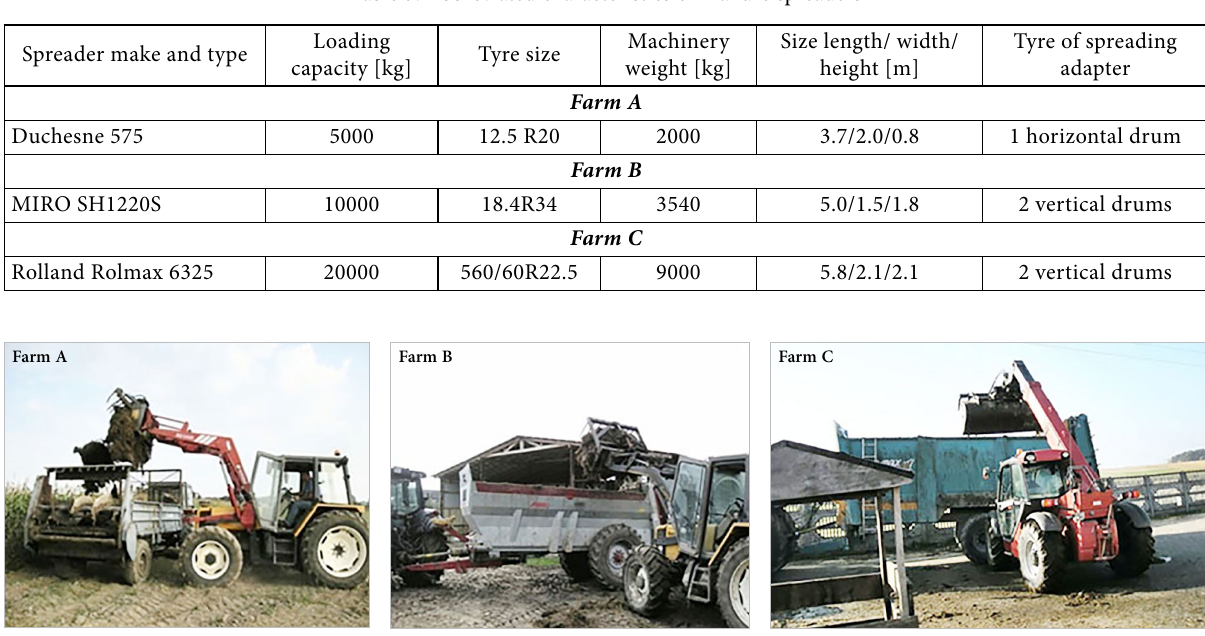
Table 3. Abbreviated characteristics of manure spreaders